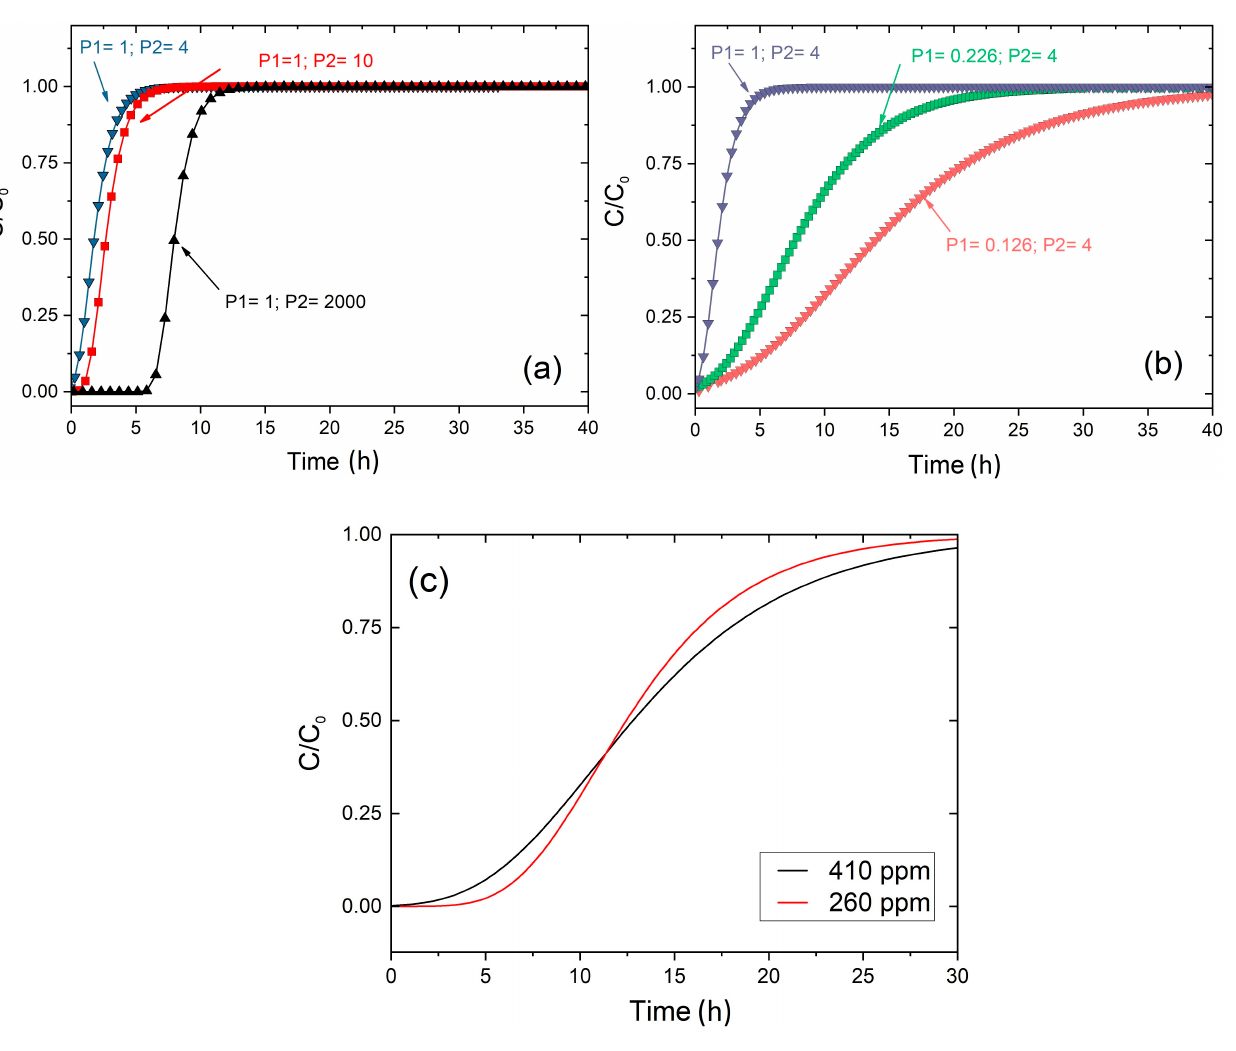
Figure 5. Modeling of breakthrough curves based on the deactivation model in linearized form changing the kinetic parameters noted by P1 and P2: ( a ) P1 remains constant, while the P2 value varies; ( b ) P2 remains constant, while the P1 value varies; ( c ) simulation of breakthrough curves at 25000 h − 1 GHSV, 600 °C as temperature, and LB equal to 1.5 cm for two different H 2 S concentrations used in present